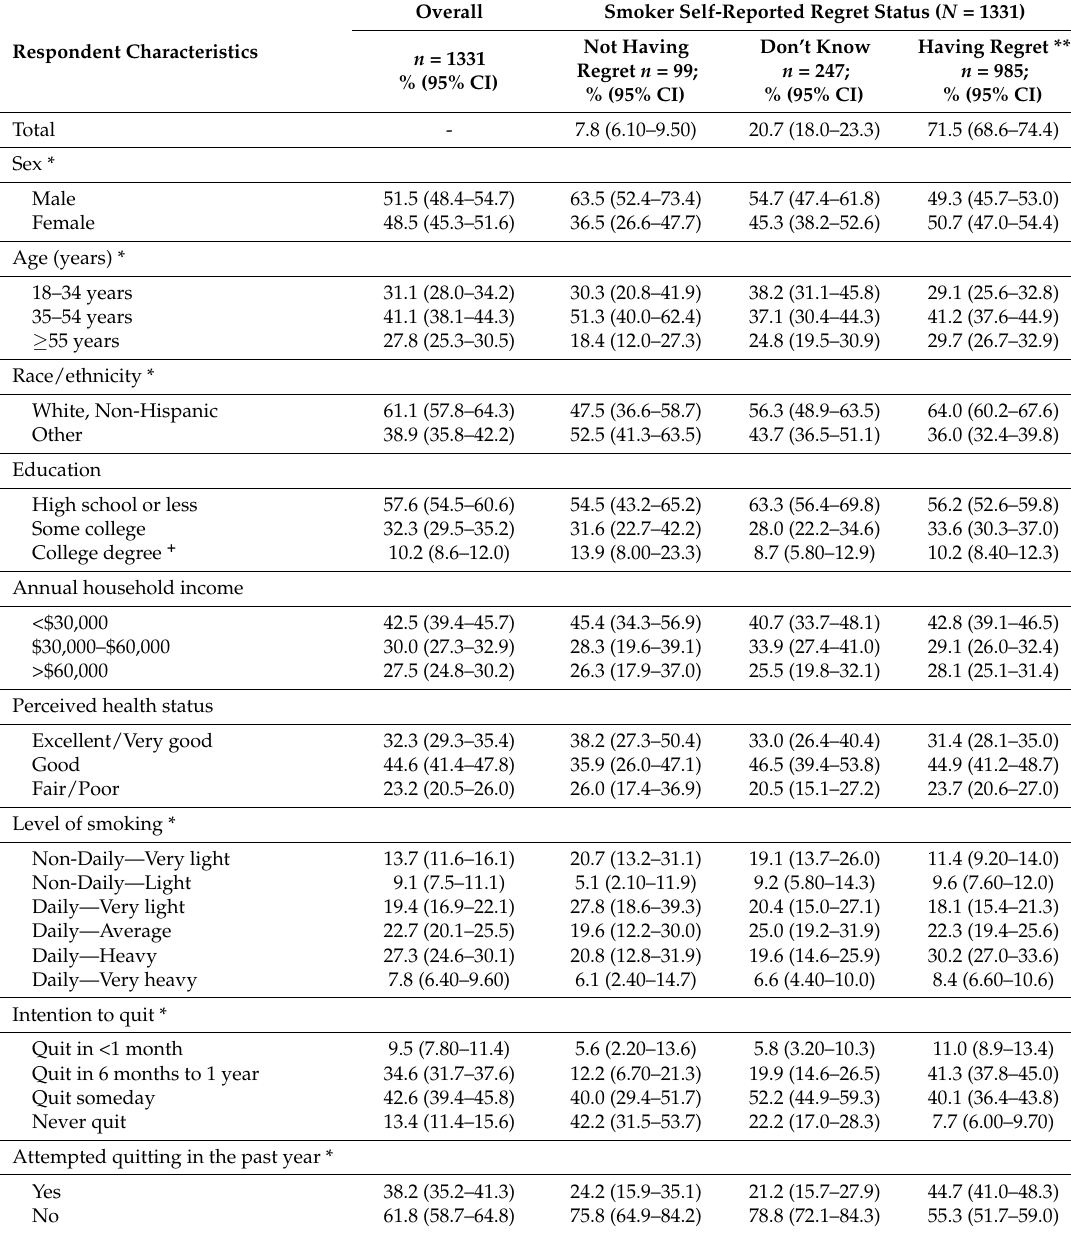
Table 1. Smoker’s regret by respondent characteristics among U.S. adults,